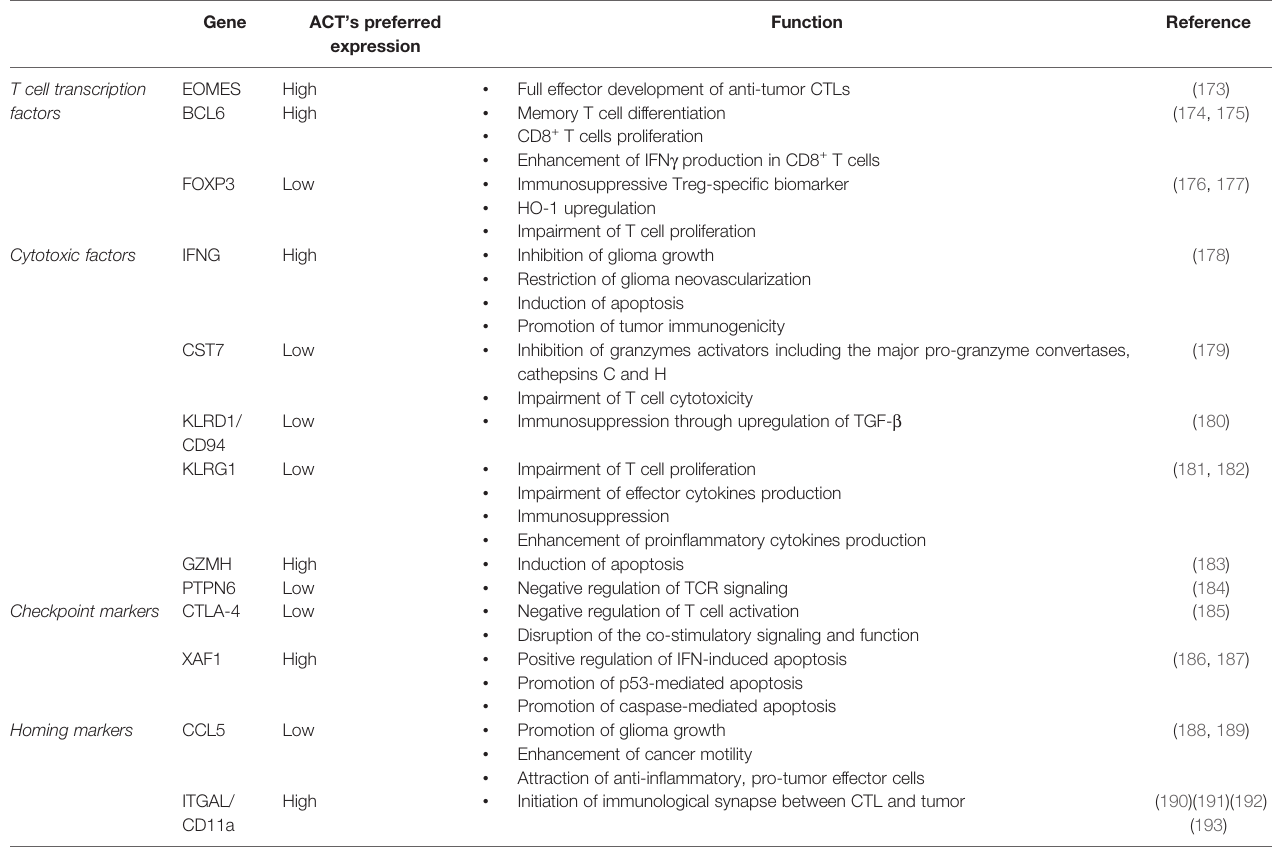
TABLE 2 | The genetic pro fi le of ACT products and their association with antitumor immune response. Gene ACT ’ s preferred expression